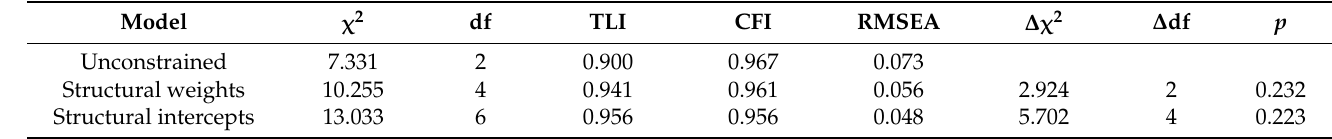
Table 4. Multigroup analysis according to type of employment.